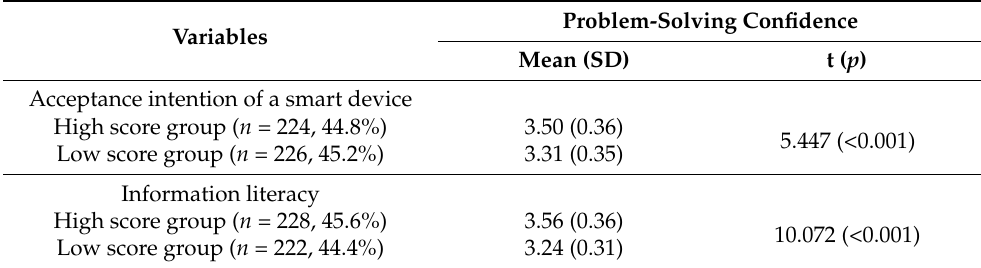
Table 3. Differences in problem-solving confidence according to acceptance intention of a smart device and information literacy ( N =